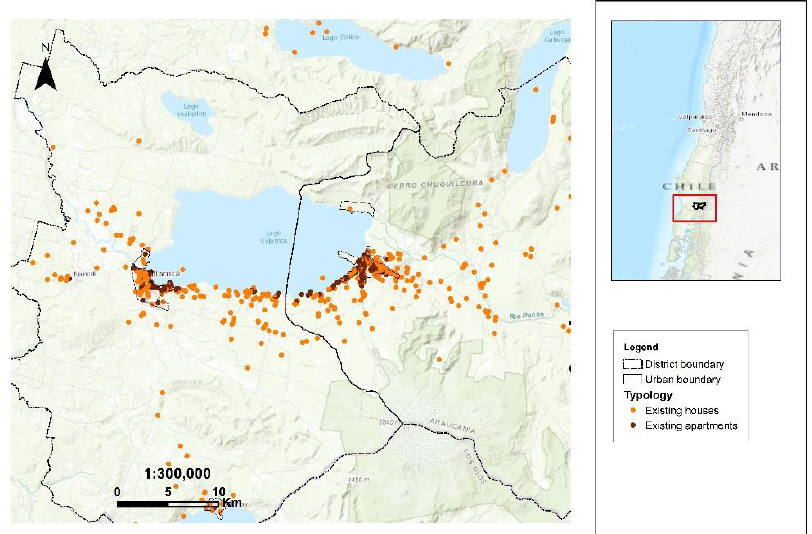
Figure 9. Existing houses and apartments currently for sale in the districts of Villarrica and Pucón. Source: compiled by the authors using real estate data dated 10 November 2021.